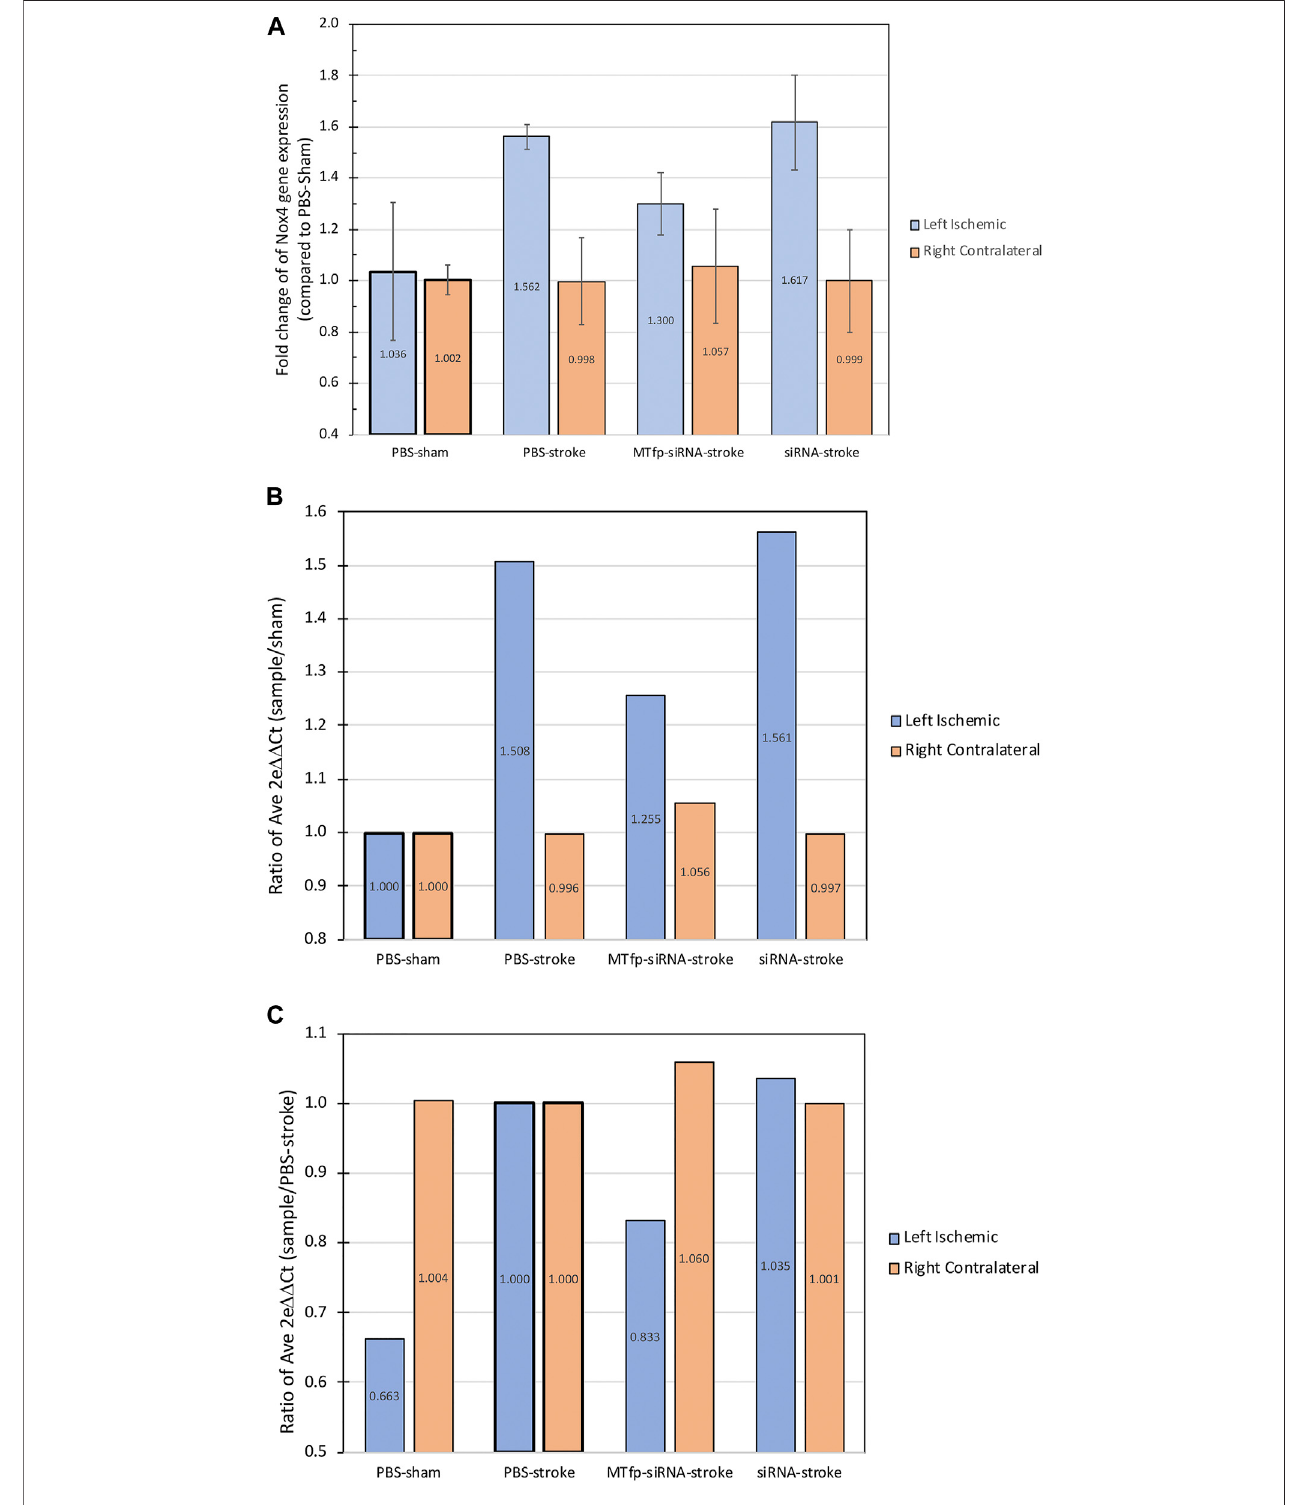
FIGURE 3 | NOX4 mRNA expression in the brain after siRNA treatment. The graphs show the fold change of Nox4 gene expression in the mouse brain hemispheres measured by qPCR following treatment and 24 h post-stroke, showing both the expression in left ischemic side and the right contralateral side. (A) Values are normalized to β -actin gene expression and individualsamplesarecomparedtothecorrespondingaverage PBS-shamcondition(ischemicor contralateral). Dataare shownasmean ± SEM.( n (cid:2) 2 – 4micepergroup). (B) RatioofaveragefoldchangeofeachgroupcomparedtoPBS-sham. (C) Ratioofaveragefoldchangeofeach groupcomparedtoPBS-stroke. “ Leftischemic ” inblue,referstothemeasurmentsintheleftstroke-inducedhemisphereand “ Rightcontralateral ” inorange,referstothe measurement in the right non-stroke hemisphere. Raw data and calculations are shown in Supplementary Table S3 .